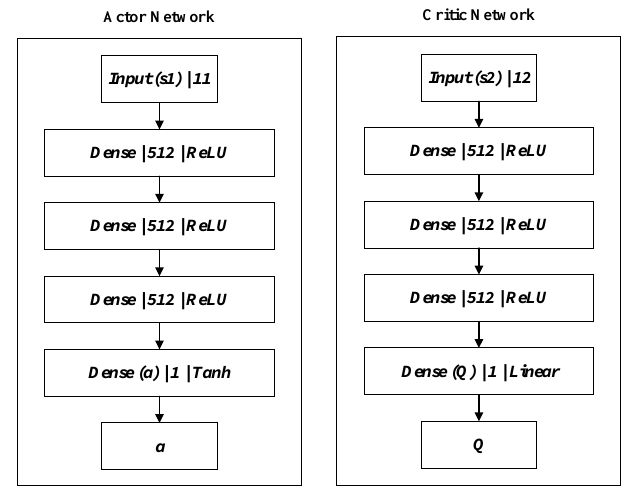
Figure 3. Deep deterministic policy gradient (DDPG) network structure.